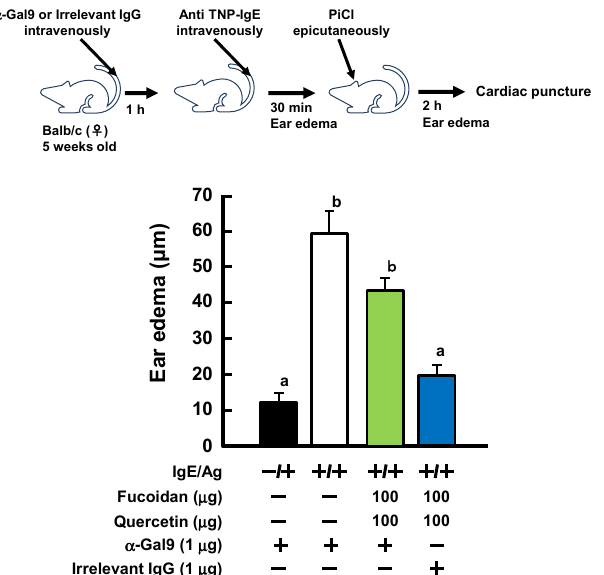
Figure 4. Involvement of galecti-9 in inhibitory effect of fucoidan and quercetin on PCA reaction. Mice were administered fucoidan and quercetin simultaneously for 4 days, and then intravenously injected with anti-gal9 antibody or isotype IgG 1 h before PCA reaction. Anti-TNP-IgE antibody was then intravenously injected and ear thickness was measured. Thirty minutes later, PiCl was applied to ear for challenge. Values represent the means ± SE of 5 mice in each group. Different superscript letter (a, b) means the significant differences ( p < 0.05; Tukey-Kramer test). 2.5. Effect of Extract from Broccoli and Okra on Anti-Allergic Activity of Fucoidan in PCA Reaction